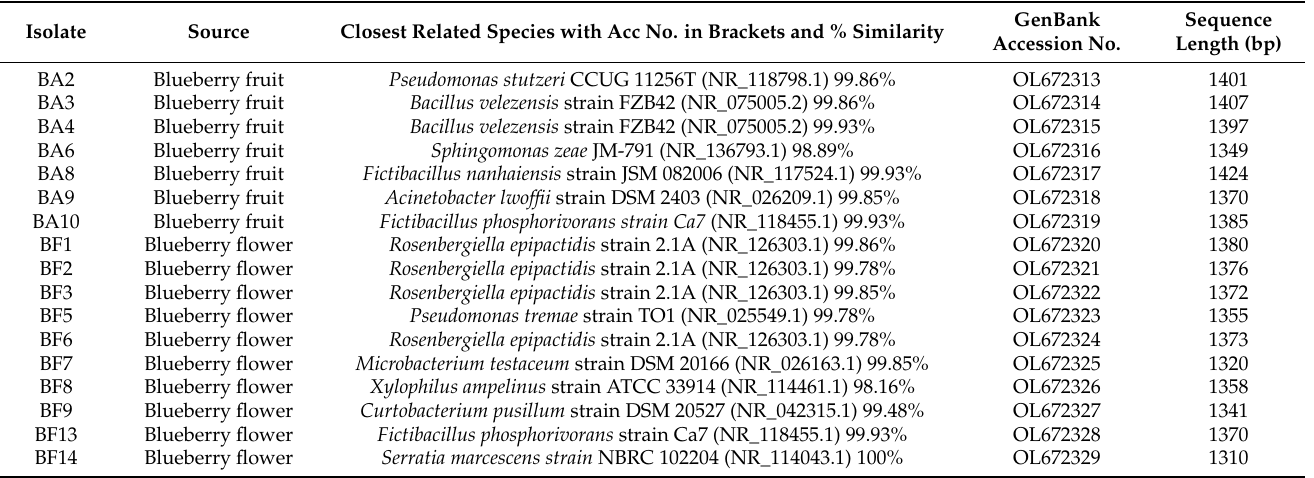
Table 1. Identification of bacterial isolates from blueberries based on 16S rRNA gene